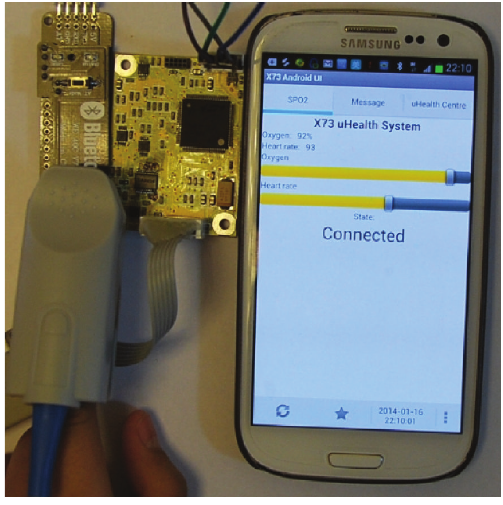
Figure 17: The X73 uHealth system testbed prototype.